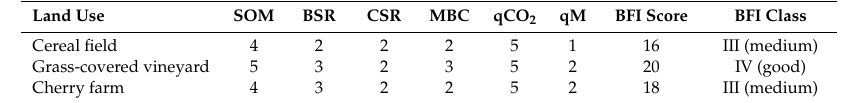
Table 5. Scores of the soil parameters and biological fertility index for the di ff erent land uses. Land Use